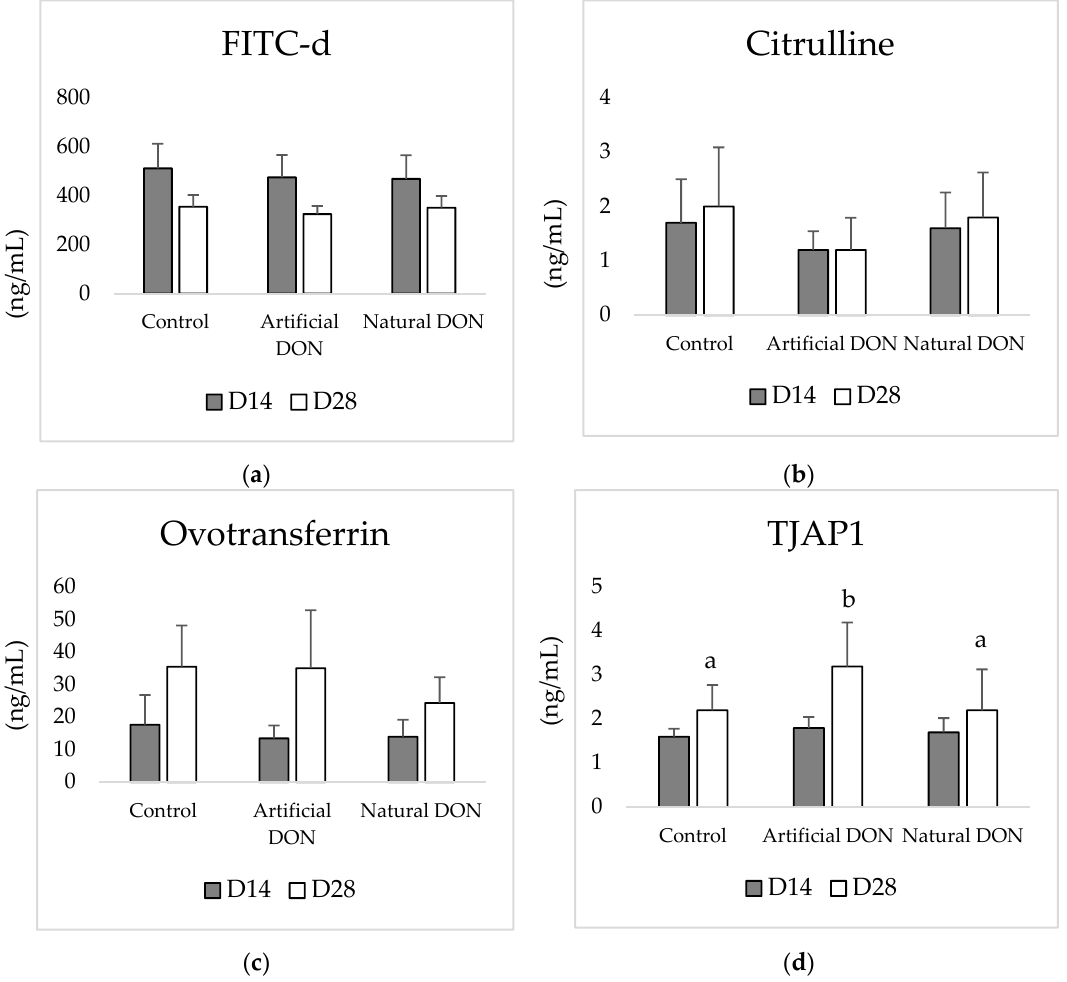
Figure 2. Effect of experimental diets on serum levels of: ( a ) FITC-d; ( b ) citrulline; ( c ) ovotransferrin; ( d ) tight junction associated protein 1 (TJAP1). a,b Different superscripts indicate significant differences among treatments ( p ≤ 0.05).